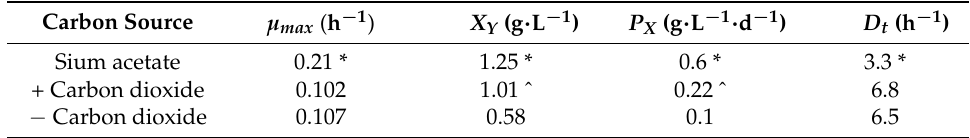
Table 1. Biological parameters under differing growth conditions. A one-way independent ANOVA was performed to compare whether values in different treatment groups we significantly different from one another. Values marked with * indicate significance between sodium acetate treatment and +/ − carbon dioxide treatments. While values marked with ˆ indicate a significant difference between + carbon dioxide against—carbon dioxide ( p ≤